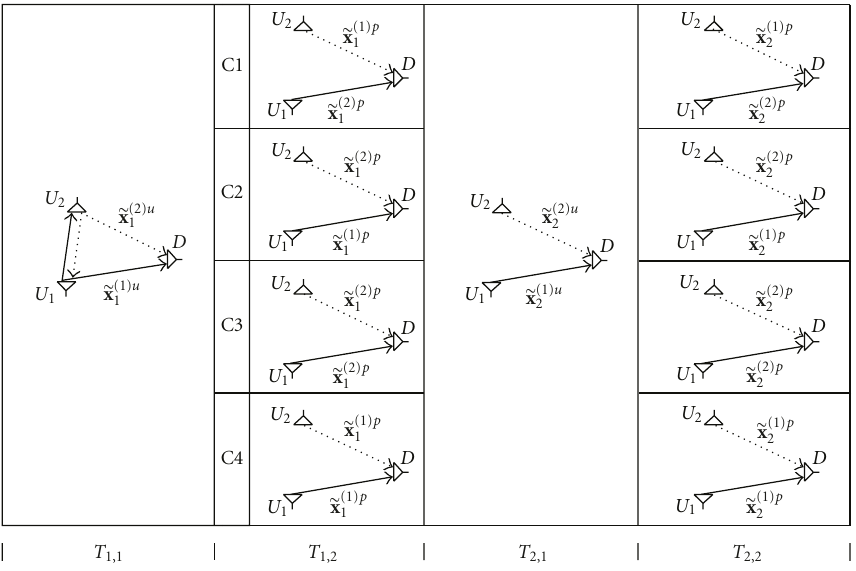
Figure 3: Scheme A: users do not know if the other cooperates or not.